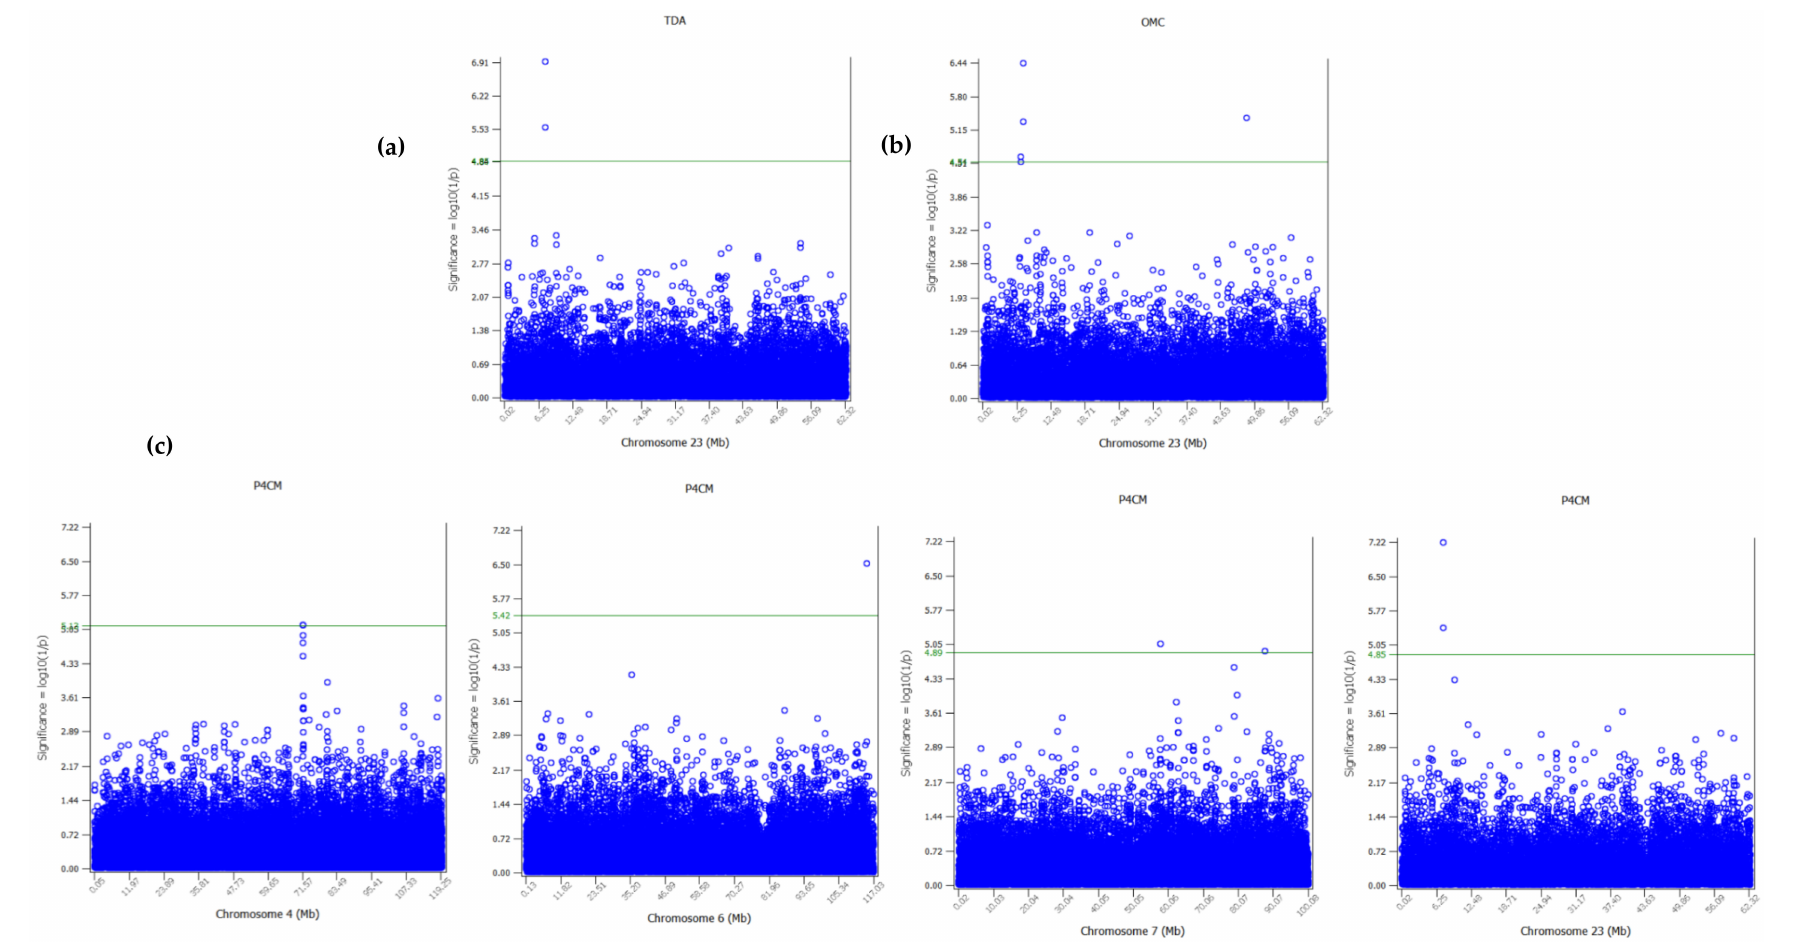
Figure 1. Manhattan plots of chromosome-wise association studies of ( a ) total days of anoestrous (TDA), ( b ) oestrous cycling month (OCM) and ( c ) progesterone cycling month (P4CM) traits. Only chromosomes with significant SNPs are shown. The horizontal green line in Manhattan plots corresponds to the average threshold value for an FDR of 10% evaluated at the chromosomal